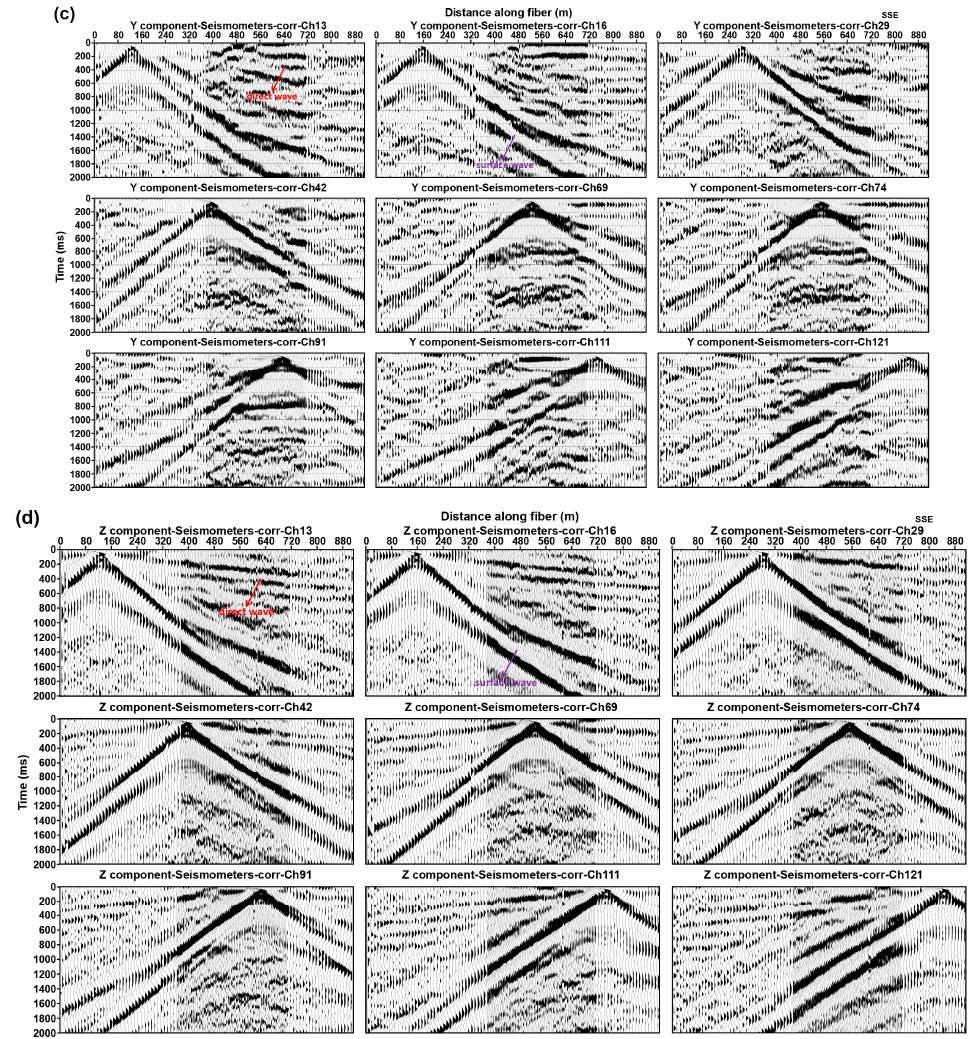
Figure 5. Examples of the multi-offset CC result based on 5 h DAS ( a ) and three-component micro- tremor data ( b – d ), respectively. To increase the SNR ratio, we stack the casual and acasual traces linearly.